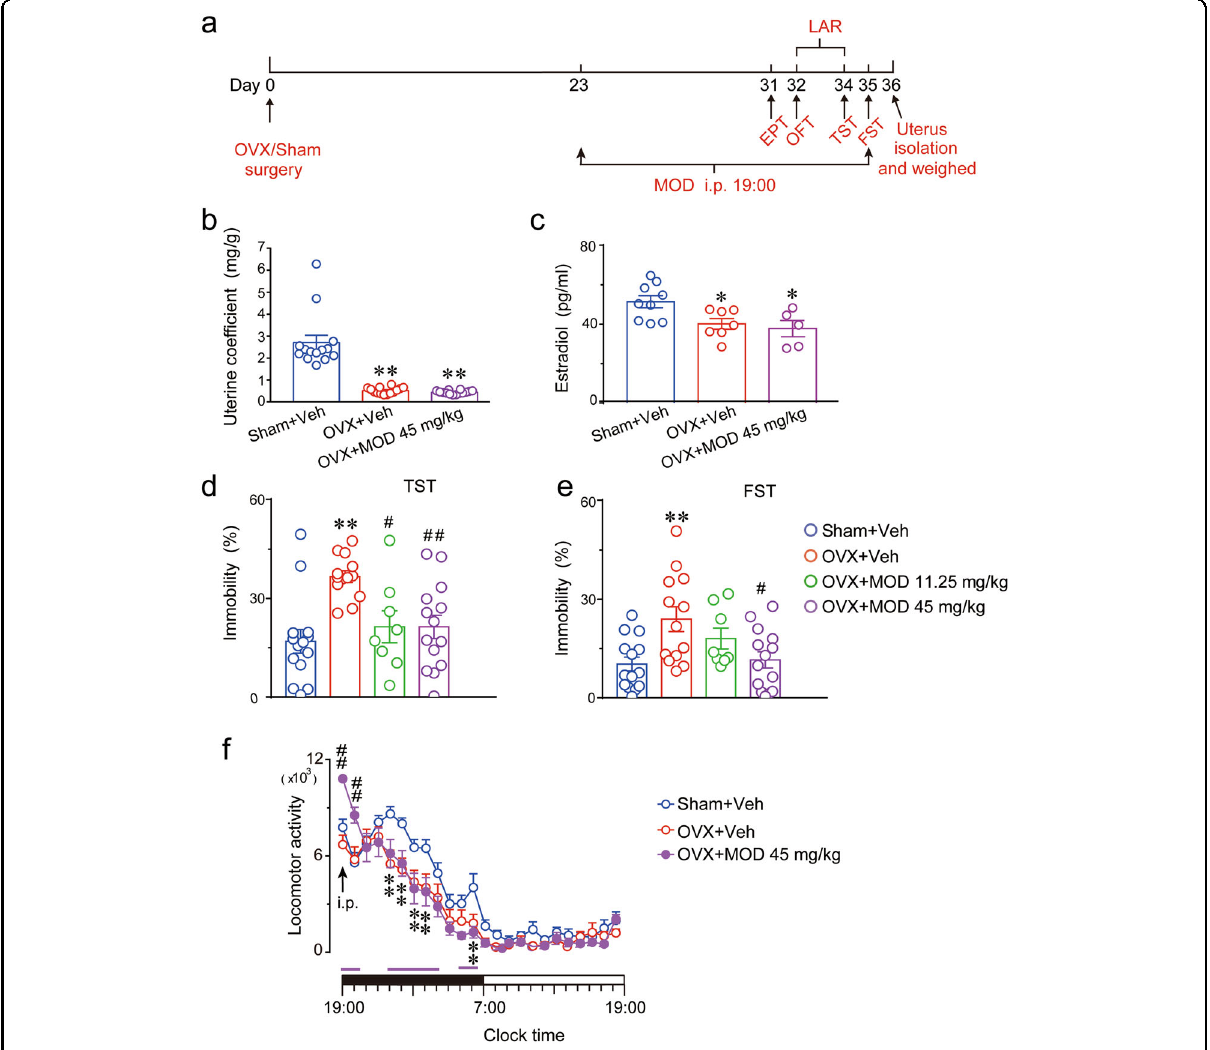
Fig. 1 Moda fi nil reverses depressive-like behaviors but has no effects on the reduction of uterus weight and estradiol concentration in ovariectomized mice. a Behavioral tests were conducted during the moda fi nil (MOD) administration. On the day after the last MOD injection, the uterus of each mouse was separated and weighed. b The uterus coef fi cient was calculated as ratio of the uterine weight and body weight of each mouse at the end of the experimental sequences after 13-day MOD administration. n = 14 per group. c The concentration of estradiol in serum determined by enzyme-linked immunosorbent assay in each group. Sham + Vehicle (Veh): n = 9; OVX + Veh: n = 7; OVX + MOD 45 mg/kg: n = 5. d , e Percentage of immobility time in the TST ( d ) and FST ( e ) carried out at 11 days and 12 days, respectively, after MOD injections. Sham + Veh, OVX + MOD 45 mg/kg: n = 14 per group, OVX + Veh: n = 13, OVX + MOD 11.25 mg/kg: n = 8. * p < 0.05, ** p < 0.01 compared with the Sham + Veh group; # p < 0.05, ## p < 0.01 compared with OVX + Veh group in ( b – e ). f Time-course changes of the locomotion activity after 10 days of MOD treatment. ** p < 0.01 OVX + Veh group compared with the Sham + Veh group; horizontal pink bars under the curve indicate statistical differences ( p < 0.05) of the OVX + MOD group versus Sham + Veh group; ## p < 0.01 OVX + MOD group compared with OVX + Veh group. Sham + Veh, OVX + MOD 45 mg/kg: n = 15 per group, OVX + Veh: n = 13. The horizontal fi lled and open bars on the x -axes indicate the 12-h active phase and 12-h inactive phase, respectively. EPT elevated plus-maze test, OFT open fi eld test, LAR locomotor activity recording, TST tail suspension test, FST forced swimming